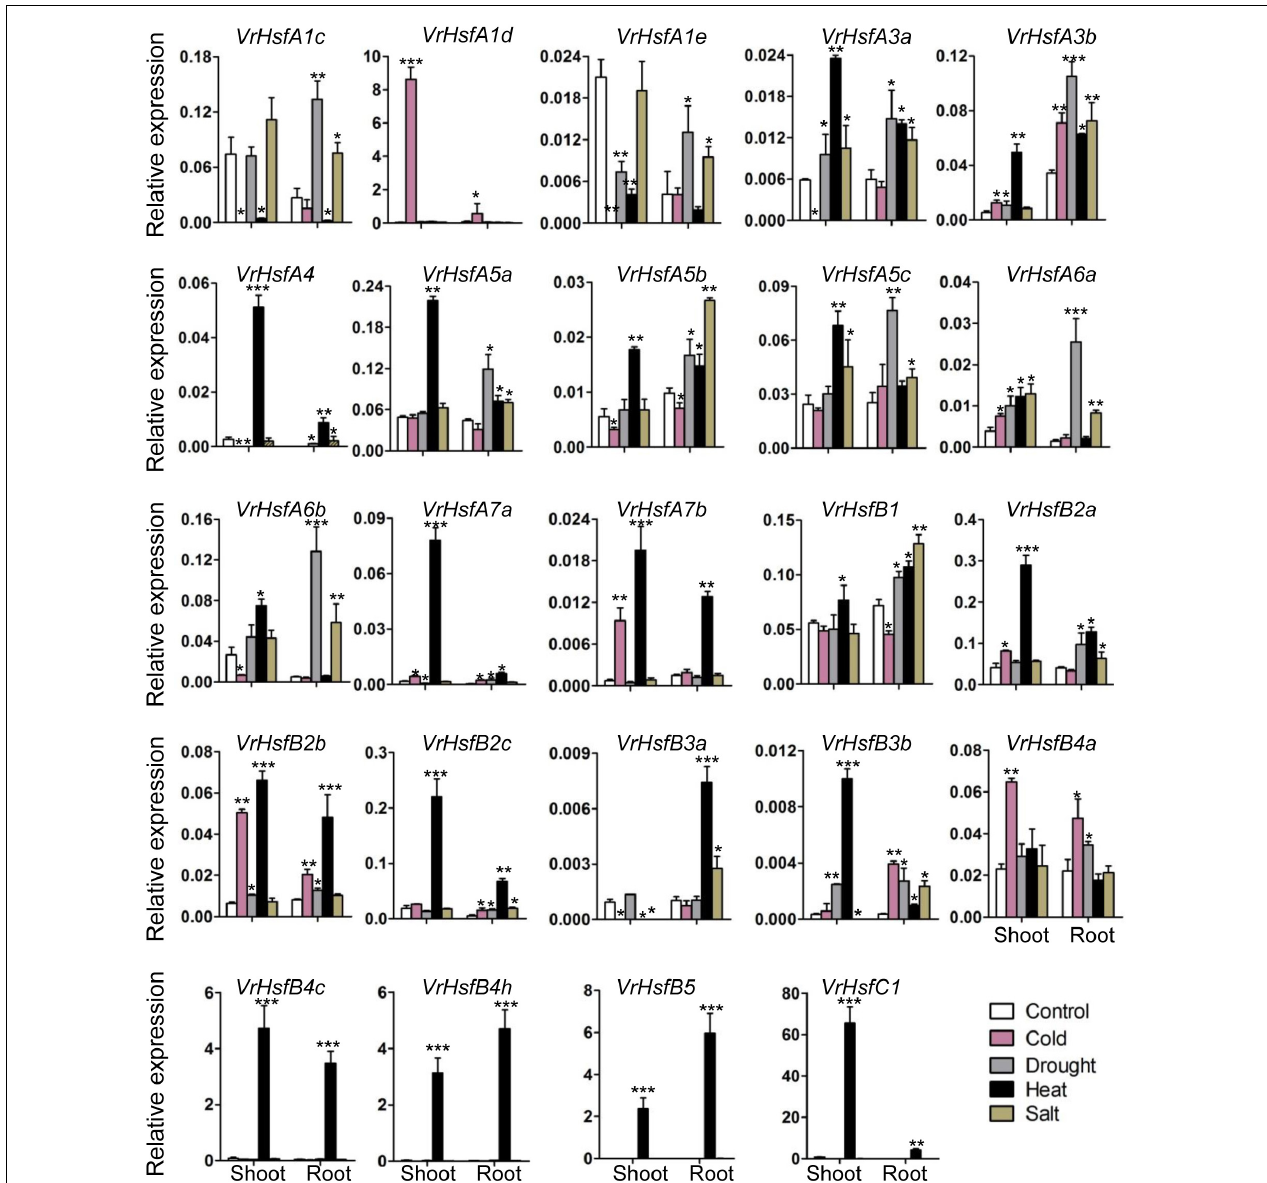
FIGURE 7 | Expression analysis of VrHsf genes in response to different stresses. Two weeks old plants were used for various stress treatments. Each sample was analyzed using three biological replicates and normalized to an Actin -expressing gene in mungbean ( Vradi03g00210 ). ∗∗∗ , ∗∗ , and ∗ are significantly different at P < 0.001, P < 0.01, and P < 0.05, respectively, compared with the relative